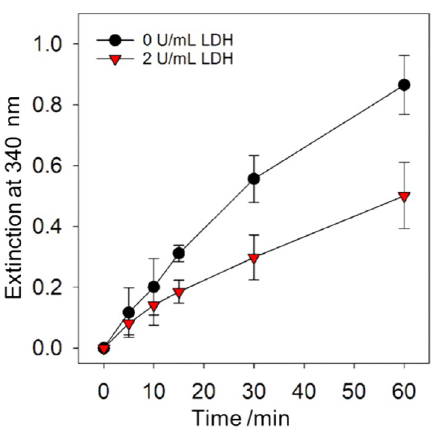
Figure 8. Extinction at 340 nm over time during electrochemical NADH regeneration from 0.1 M Tris buffer (pH 7) containing 0.75 mM NAD + and 5 mM pyruvate at − 1.3 V, with (triangle) and without (circle) addition of 2 U/mL